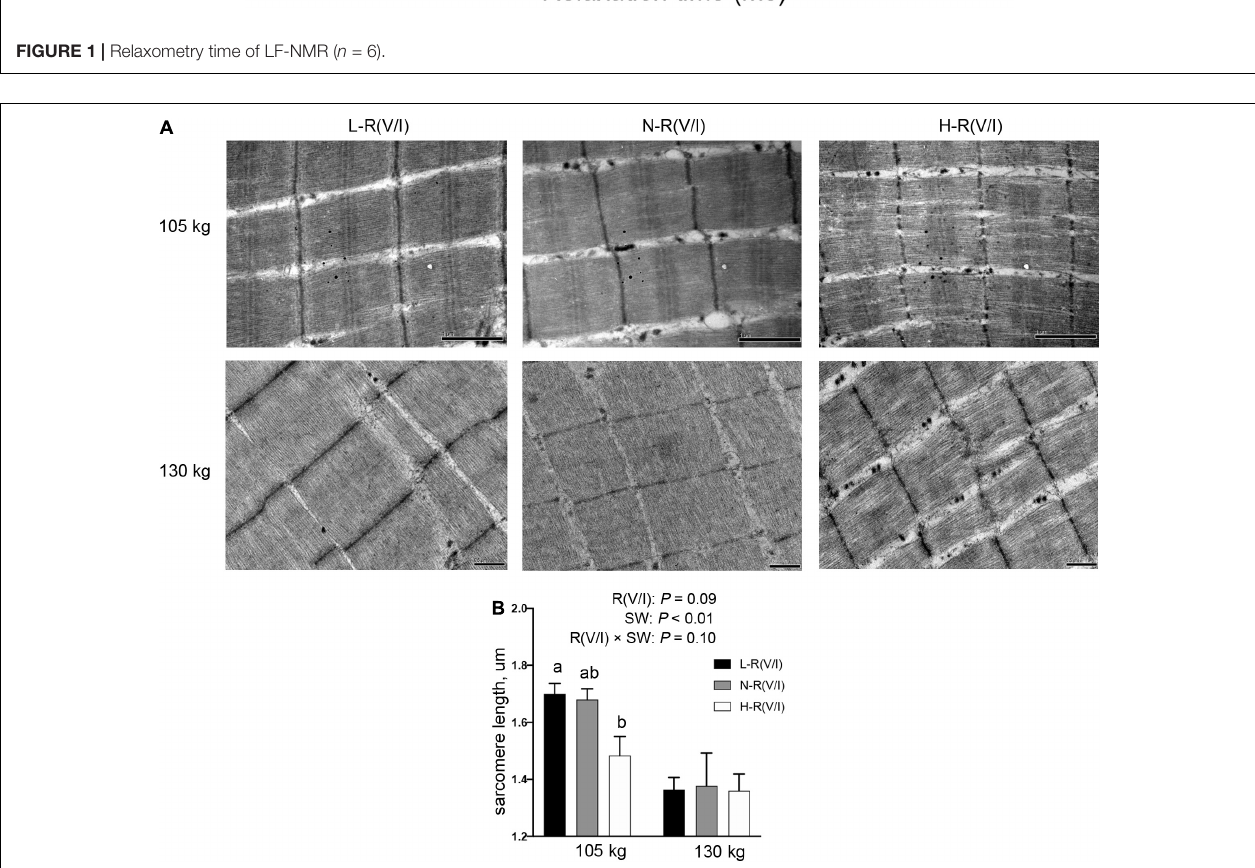
FIGURE 2 | Effects of dietary R (V/I) and slaughter weight on the ultrastructure of the M. longissimus thoracis in finishing pigs. (A) The ultrastructure of longissimus dorsi from pigs treated with diet with three R (V/I) and slaughtered at 105 or 130 kg body weight. (B) Sarcomere length of the M. longissimus thoracis. Transmission electron microscopy images at original magnifications of × 30,000. Different letters represent significant differences among the groups ( P < 0.05), n = 6.